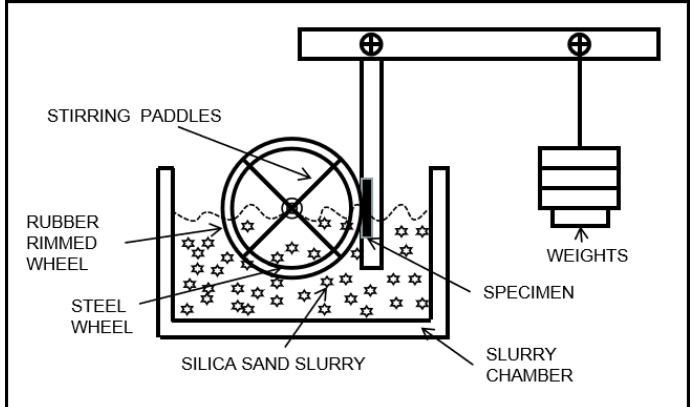
Figure 3. Schematic diagram of the wear test apparatus.